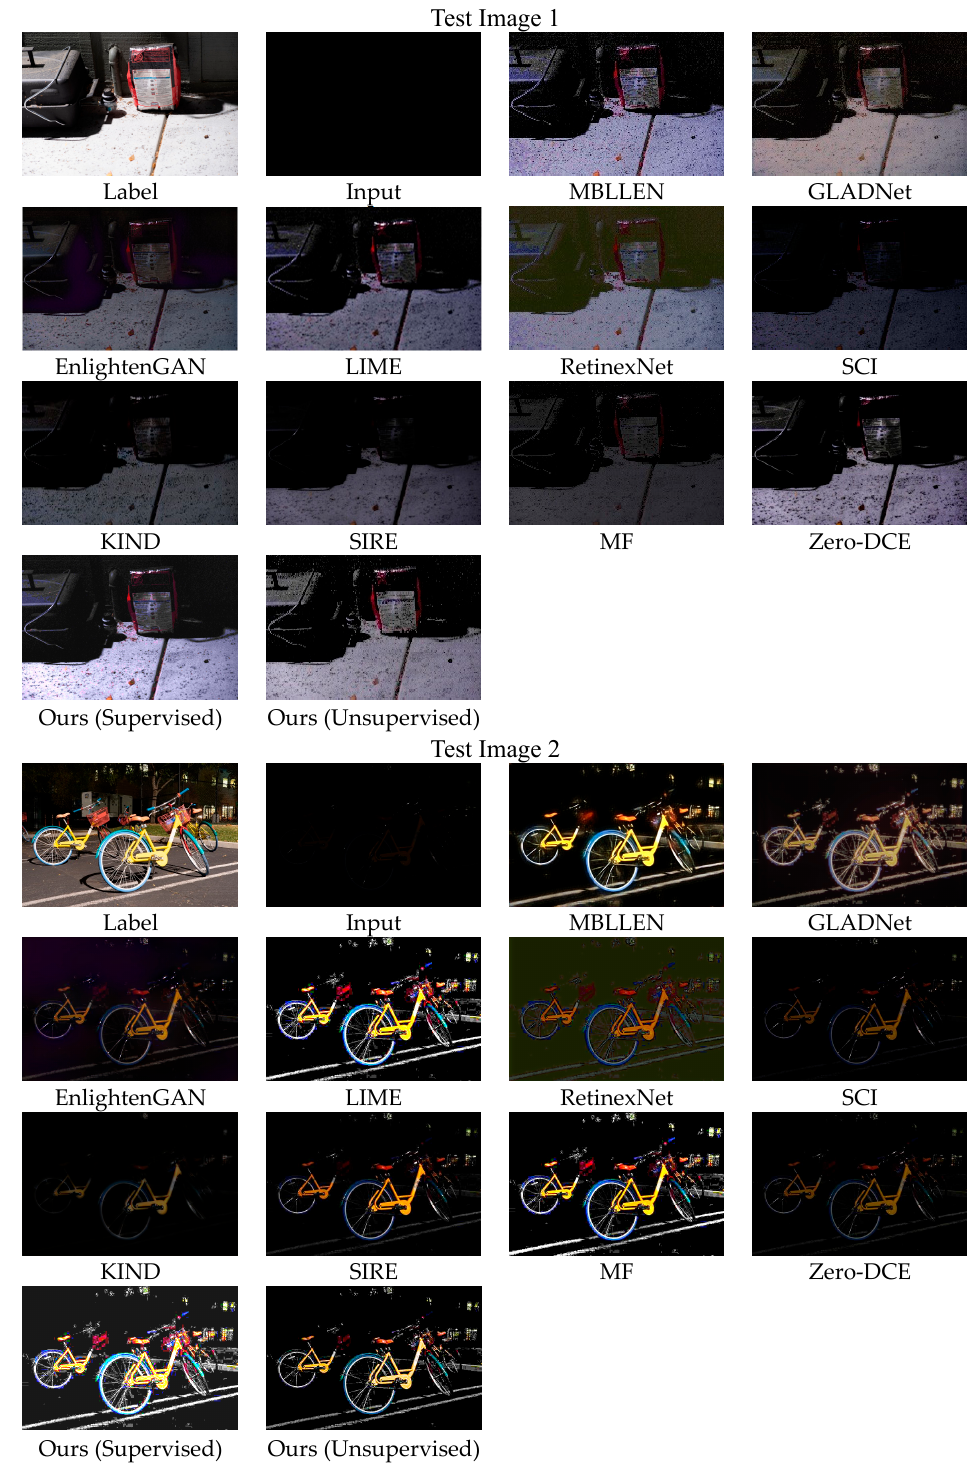
Figure 9. Comparison of the Effects of Different Algorithms in in Extremely Low-Light Conditions.